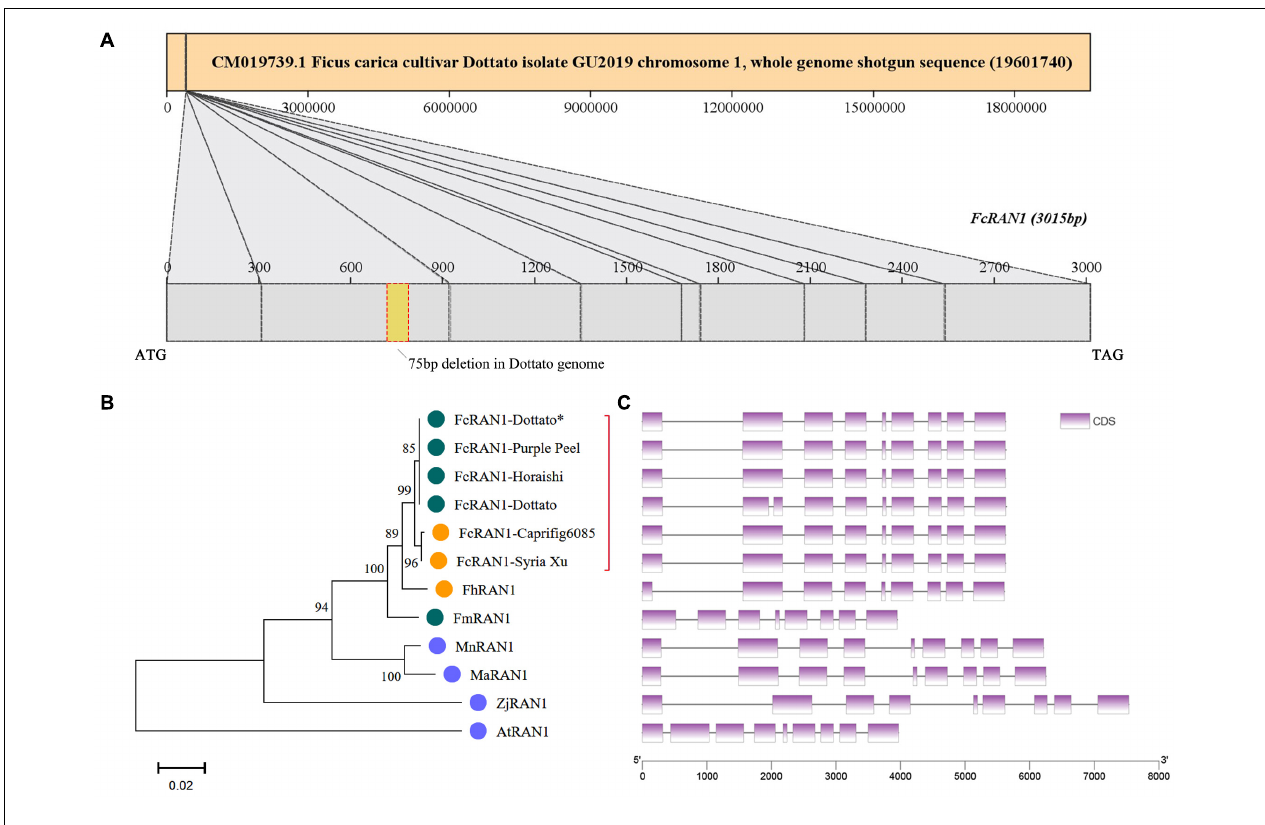
FIGURE 4 | Chromosome localization of FcRAN1 and clustering of RAN1 from several species. (A) Position of FcRAN1 on the chromosome and the fragment-deletion annotation error in the published “Dottato” genome. (B) Clustering of RAN1 -encoded proteins of various species. Red bracket highlights close clustering of RAN1s from different fig cultivars. (C) Gene structure of RAN1 in several species. Each gene in panel C corresponds to the protein to its left in panel B